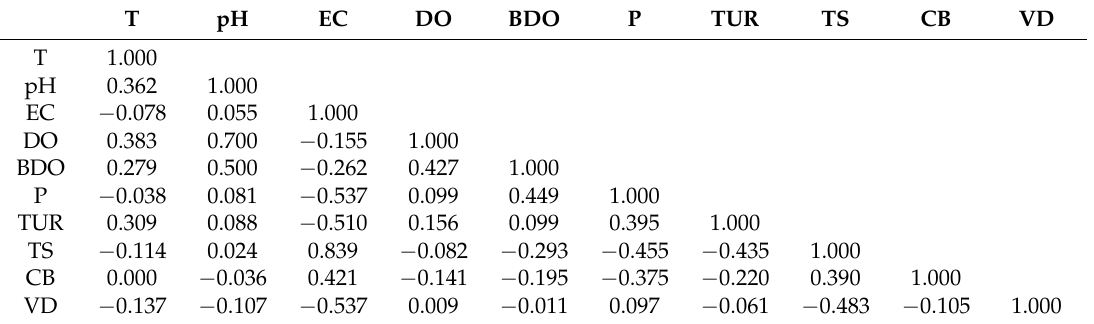
Table 2. Correlation matrix of the